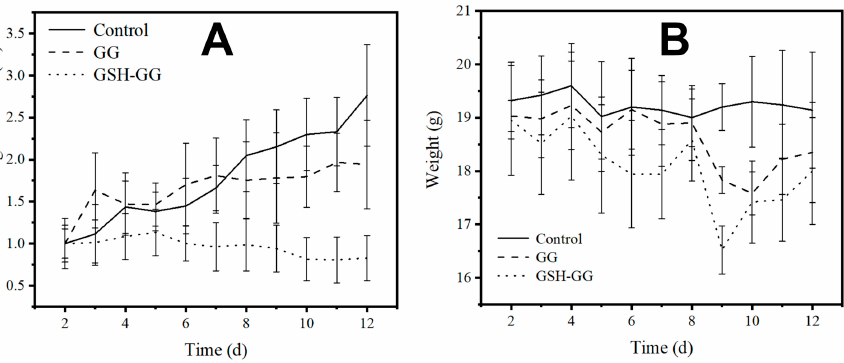
Figure 6. The tumor growth rate ( A ) and body weight ( B ) changes in 4T1 tumor bearing mice treated